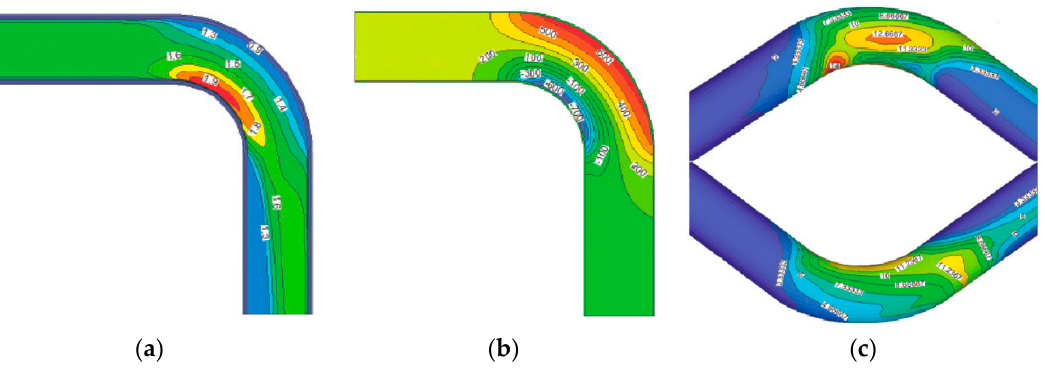
Figure 7. Calculation results of numerical simulation method in references; ( a ) Velocity cloud; ( b ) Wall shear stress cloud; ( c ) Wall shear stress cloud.